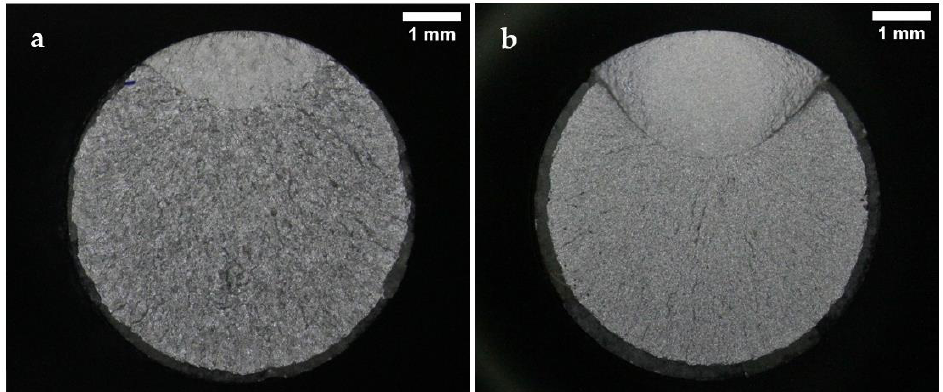
Figure 6. Fracture surfaces after fatigue tests of ( a ) A-type and ( b ) B-type H13 steels, tested in air to a maximum stress of 1200 MPa (84% and 81% YS, respectively).